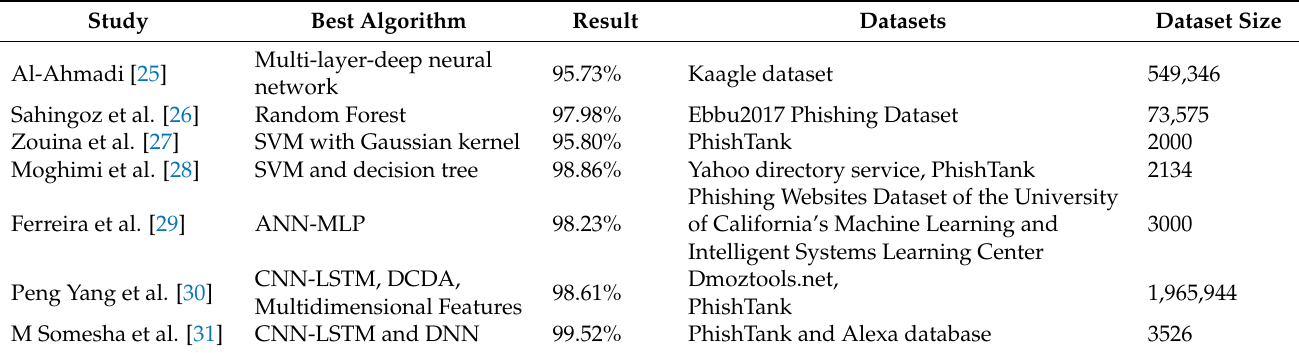
Table 1. Recent effective deep learning studies in URL phishing detection.